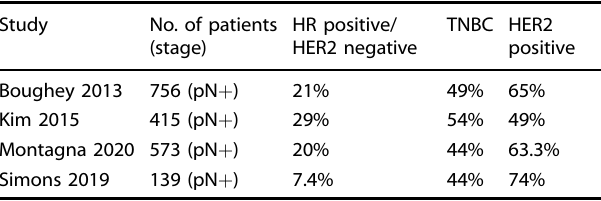
Table 1. Nodal pathologic complete response in triple-negative/HER2 positive breast cancers, and in hormone receptor-positive and HER2 negative breast cancers.